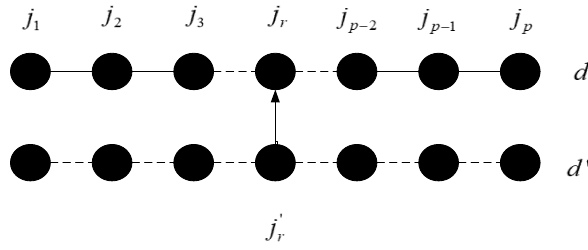
Figure 6. The mutation process of mutation operator d .